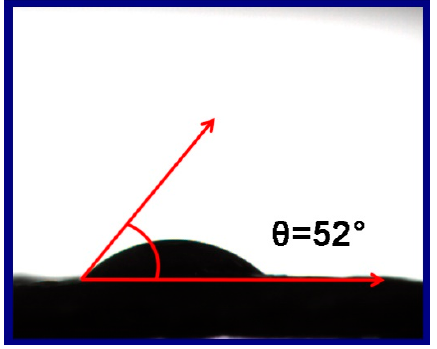
Figure 12. Water contact angle of unsupported Ru-Zn (0.60) after catalytic experiments.